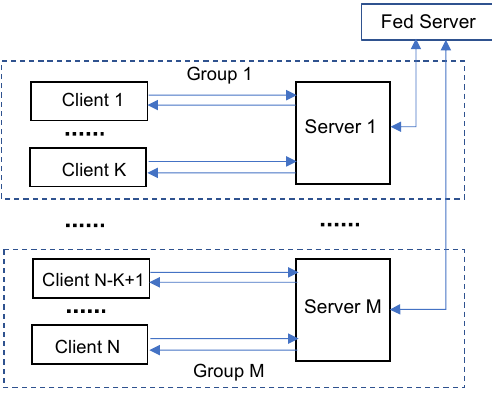
Figure 5. Generalized SplitFed (SFLG) learning framework architecture. Table 4. Key Features of representative Hybrid SL-FL